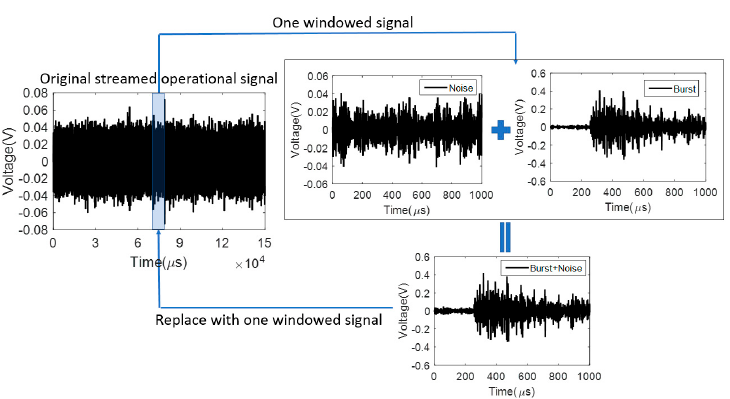
Figure 8. The schematic of signal summation.